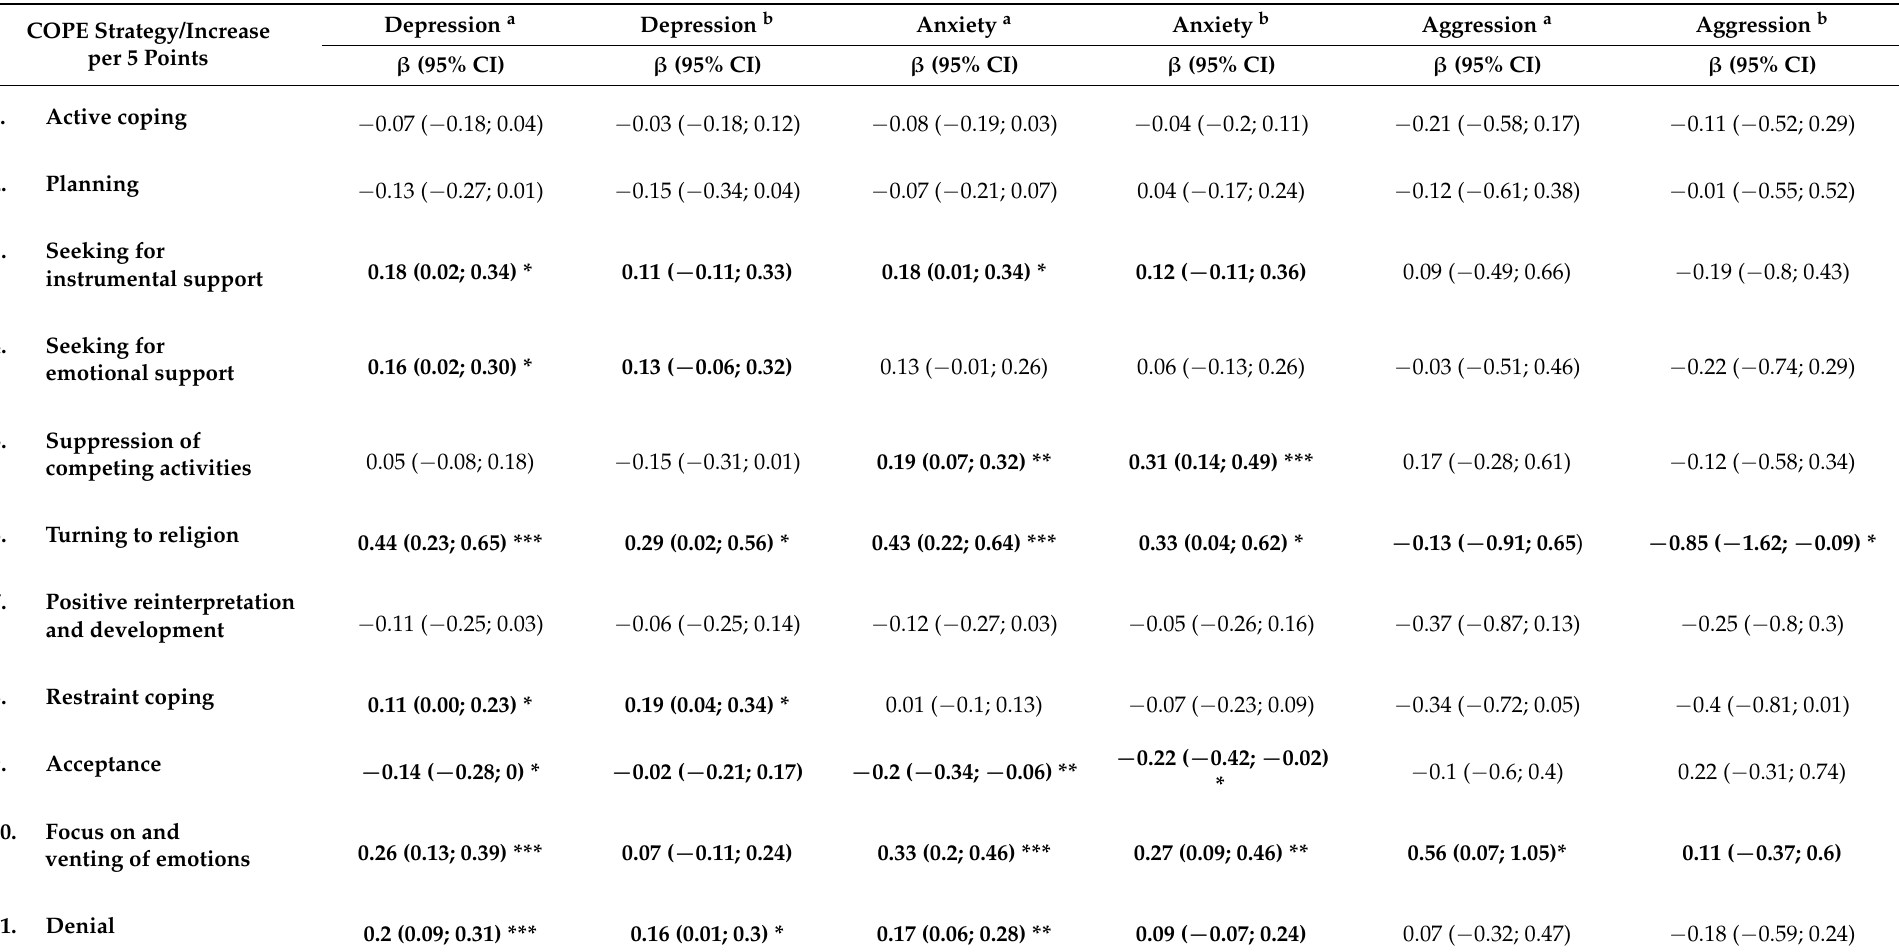
Table 8. The association between the level of parental depression, anxiety and aggression and the use of particular coping strategies including selected demographic and clinical characteristics—multivariable